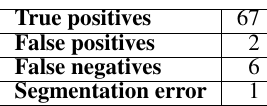
Table 6. Result housing